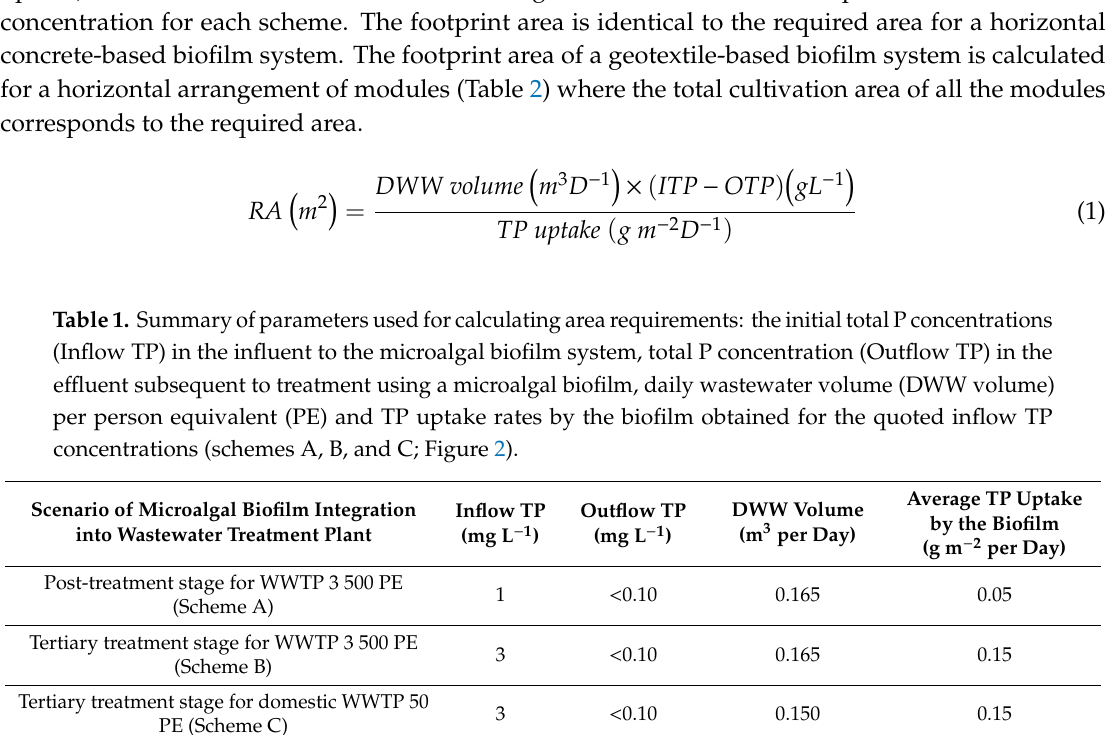
Table 1. Summary of parameters used for calculating area requirements: the initial total P concentrations (Inflow TP) in the influent to the microalgal biofilm system, total P concentration (Outflow TP) in the effluent subsequent to treatment using a microalgal biofilm, daily wastewater volume (DWW volume) per person equivalent (PE) and TP uptake rates by the biofilm obtained for the quoted inflow TP concentrations (schemes A, B, and C; Figure 2).